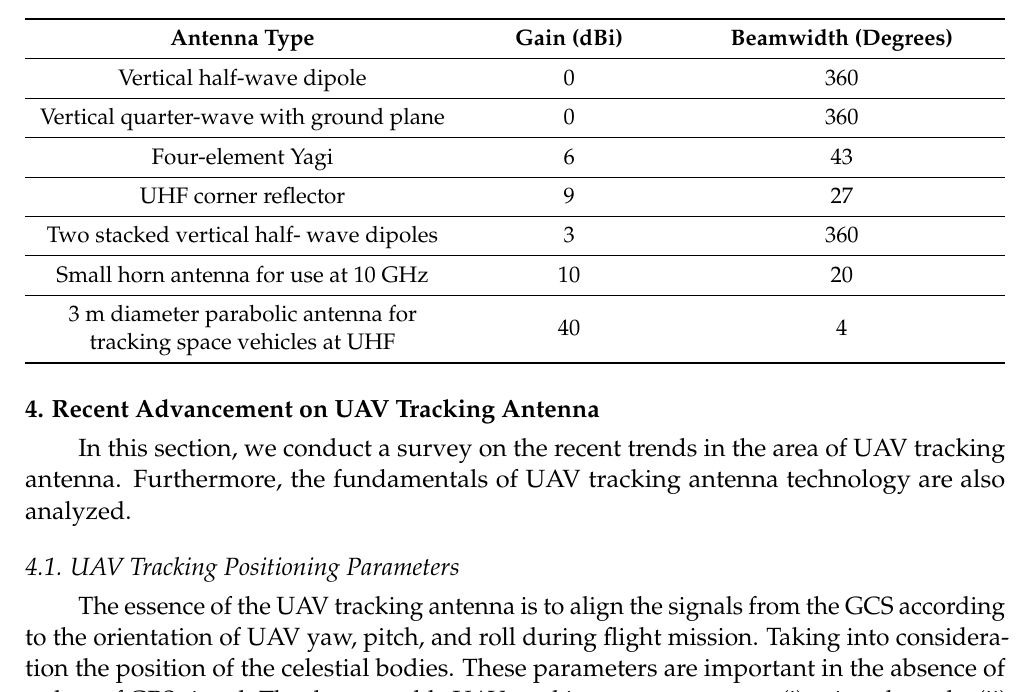
Table 1. Comparing Antenna type gain and beamwidth relationship [54].